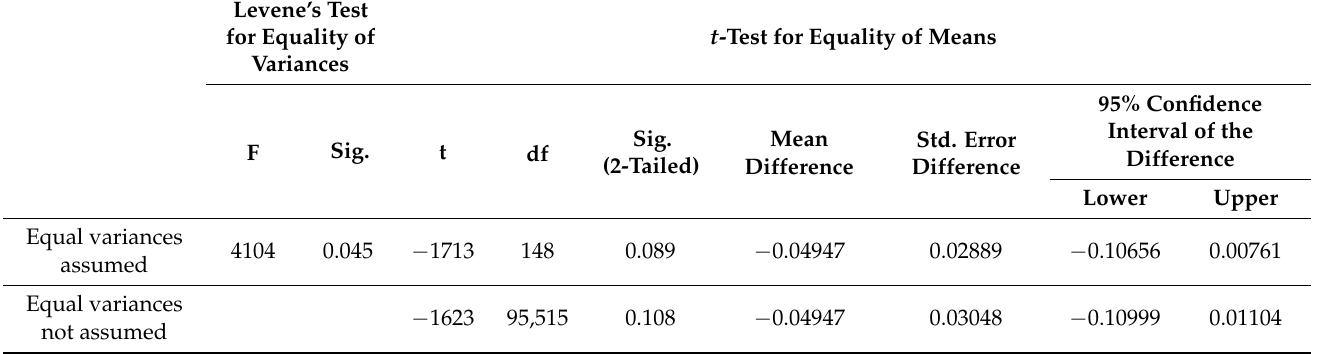
Table 3. A comparison of the experimental group and control group performance in the pre-test. The two groups were compared according to their average scores obtained before participating in the recycling